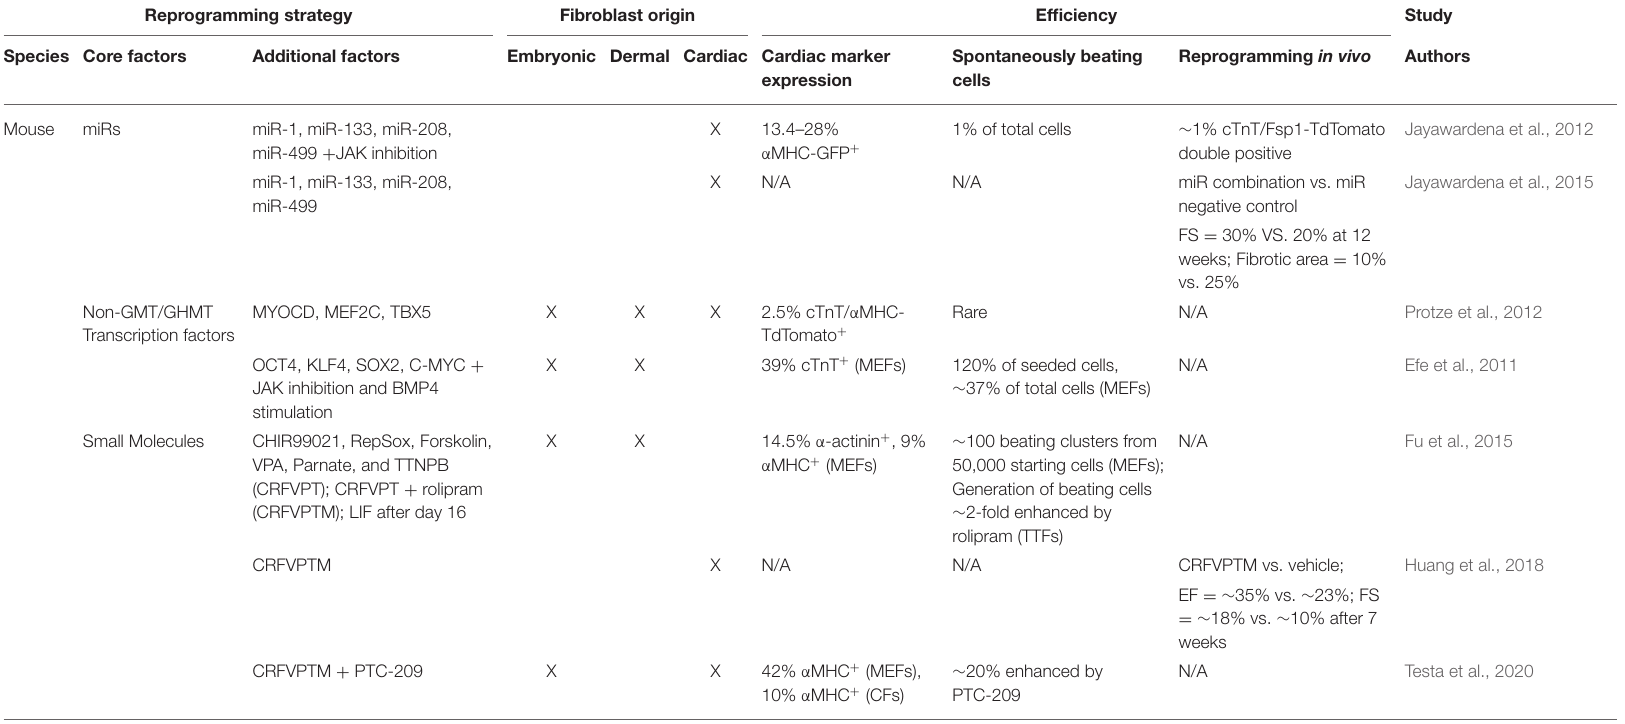
TABLE 3 | In vitro and in vivo efficiencies of non-GMT/GHMT-based reprogramming